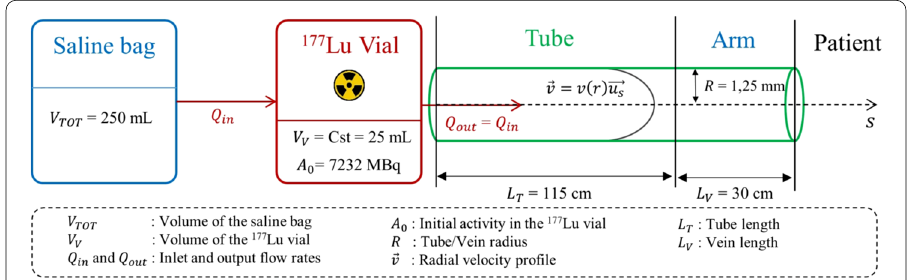
Fig. 2 Simplified geometry used to model the infusion